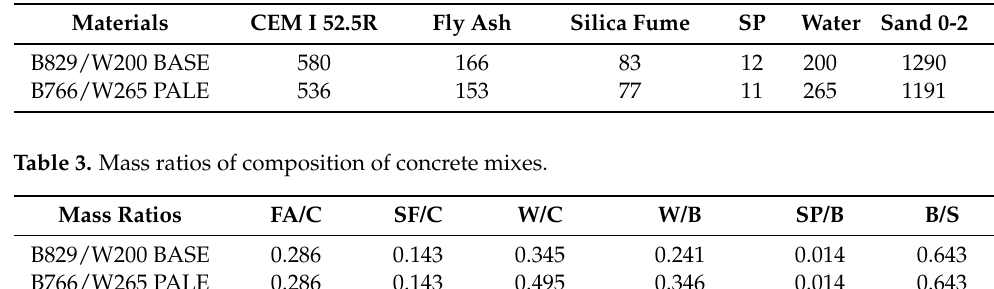
Table 2. Composition of concrete mixes, unit kg/m 3 .